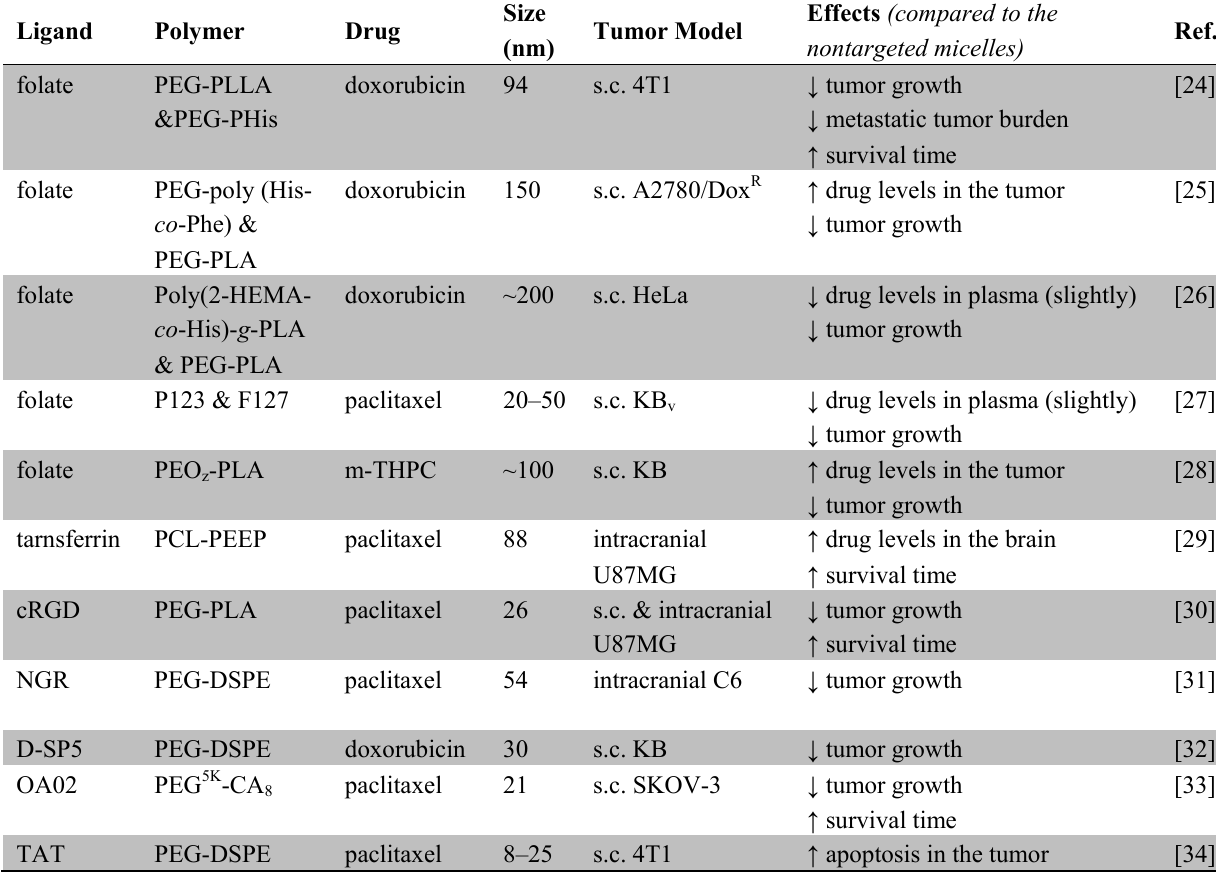
Table 2. Targeting ligands enhance the anticancer efficacy of micellar